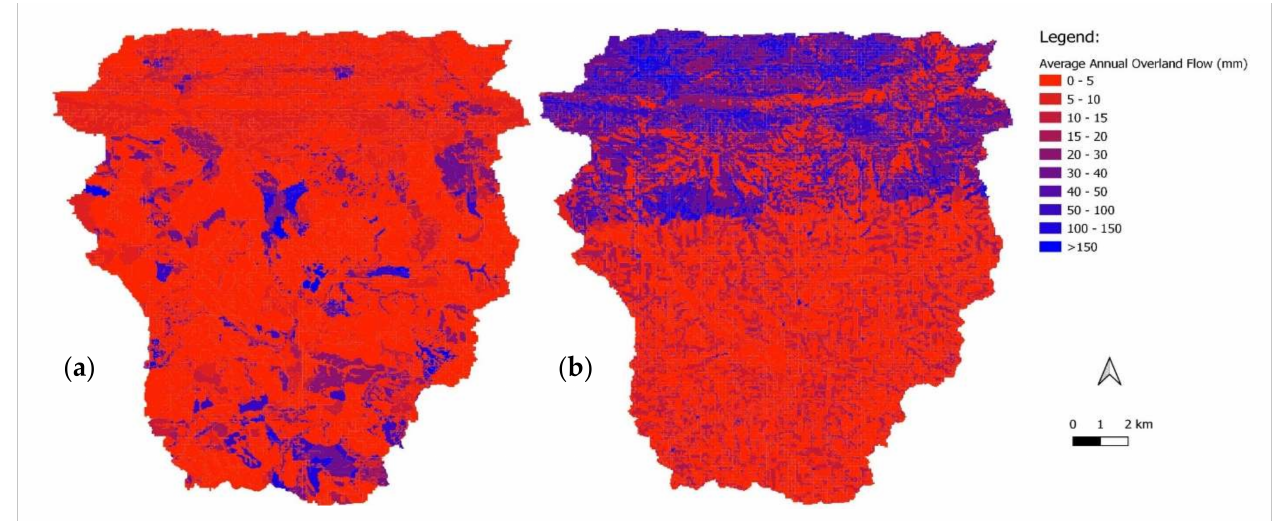
Figure 6. The average annual simulated overland flow (mm · year − 1 ) at HRU level for the ( a ) LTSM and ( b )